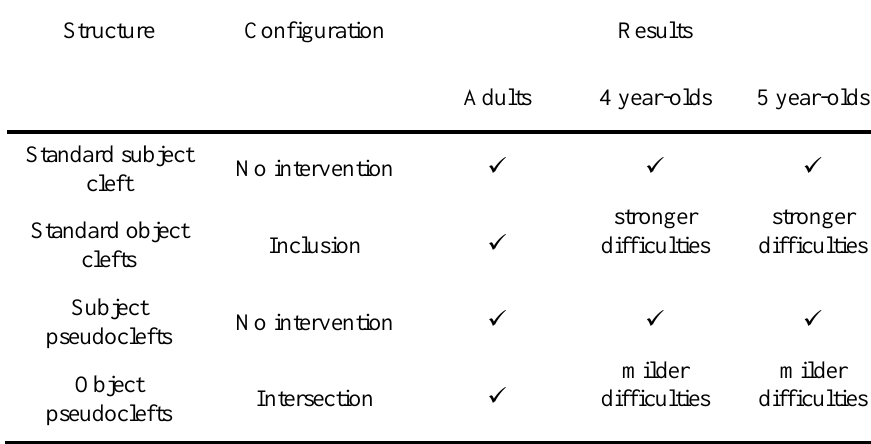
Table 2. Summary of structures, intervention configurations and